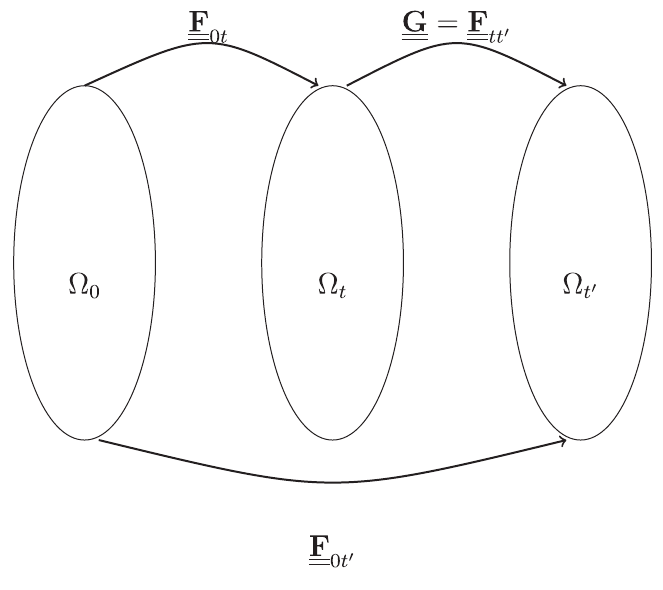
Fig. 4. Updated Lagrangian Formulation